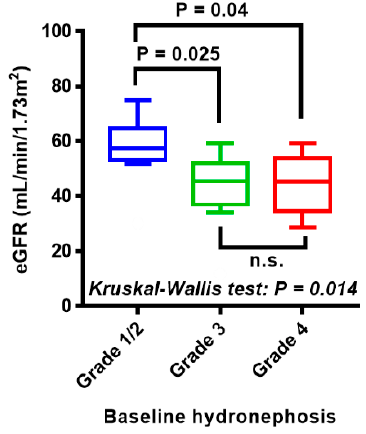
Figure 3. Association between hydronephrosis at baseline and renal function. The estimated. glomerular filtration rate (eGFR) is depicted using Tukey box plots. The horizontal lines withinboxes indicate median levels. p values are based on the Kruskal-Wallis test followed by post hoc Dunn ′ s test.